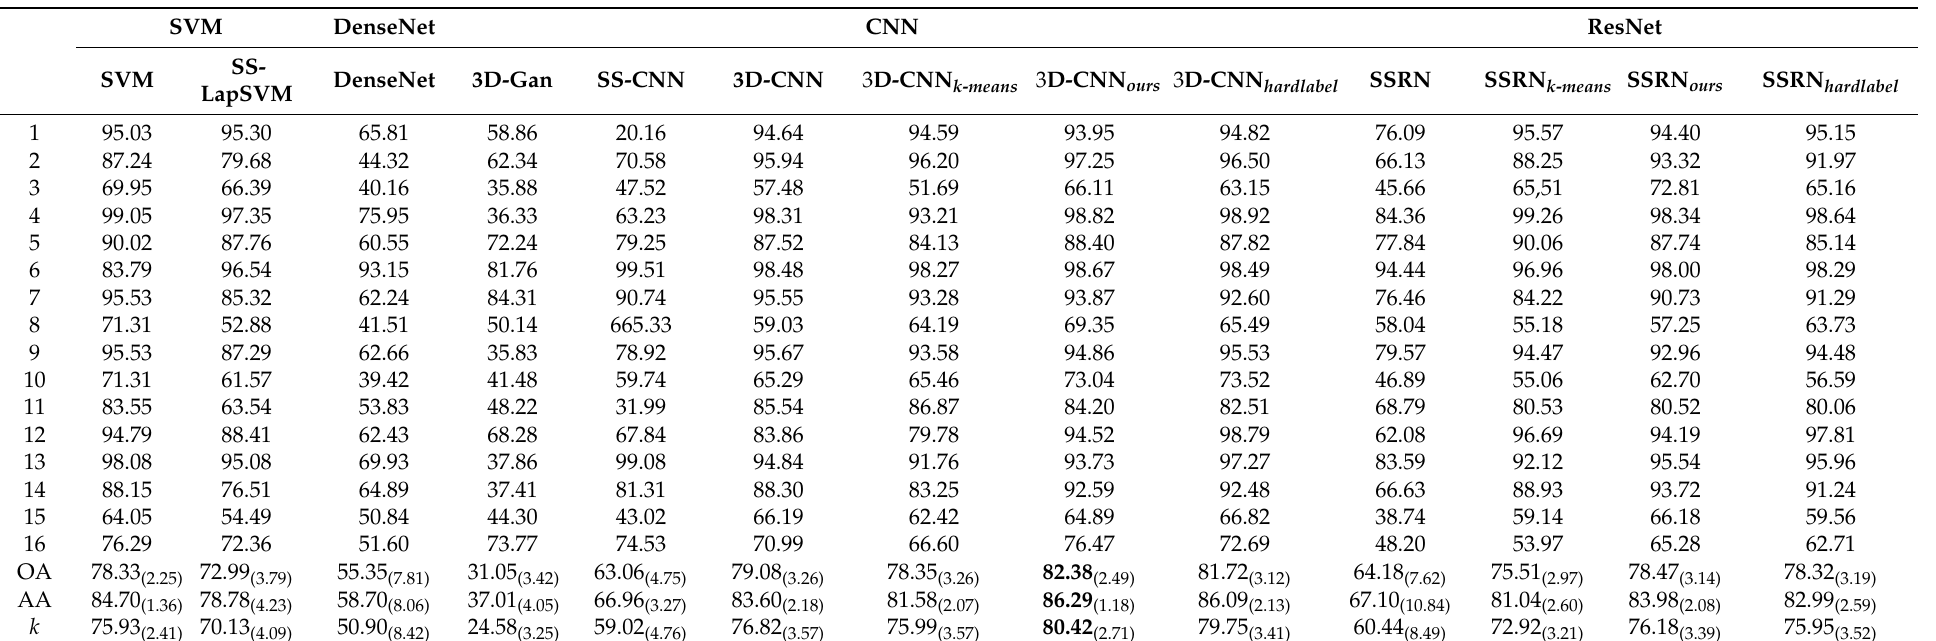
Table 4. Classification accuracy (%) for all methods with three training samples on the Salinas